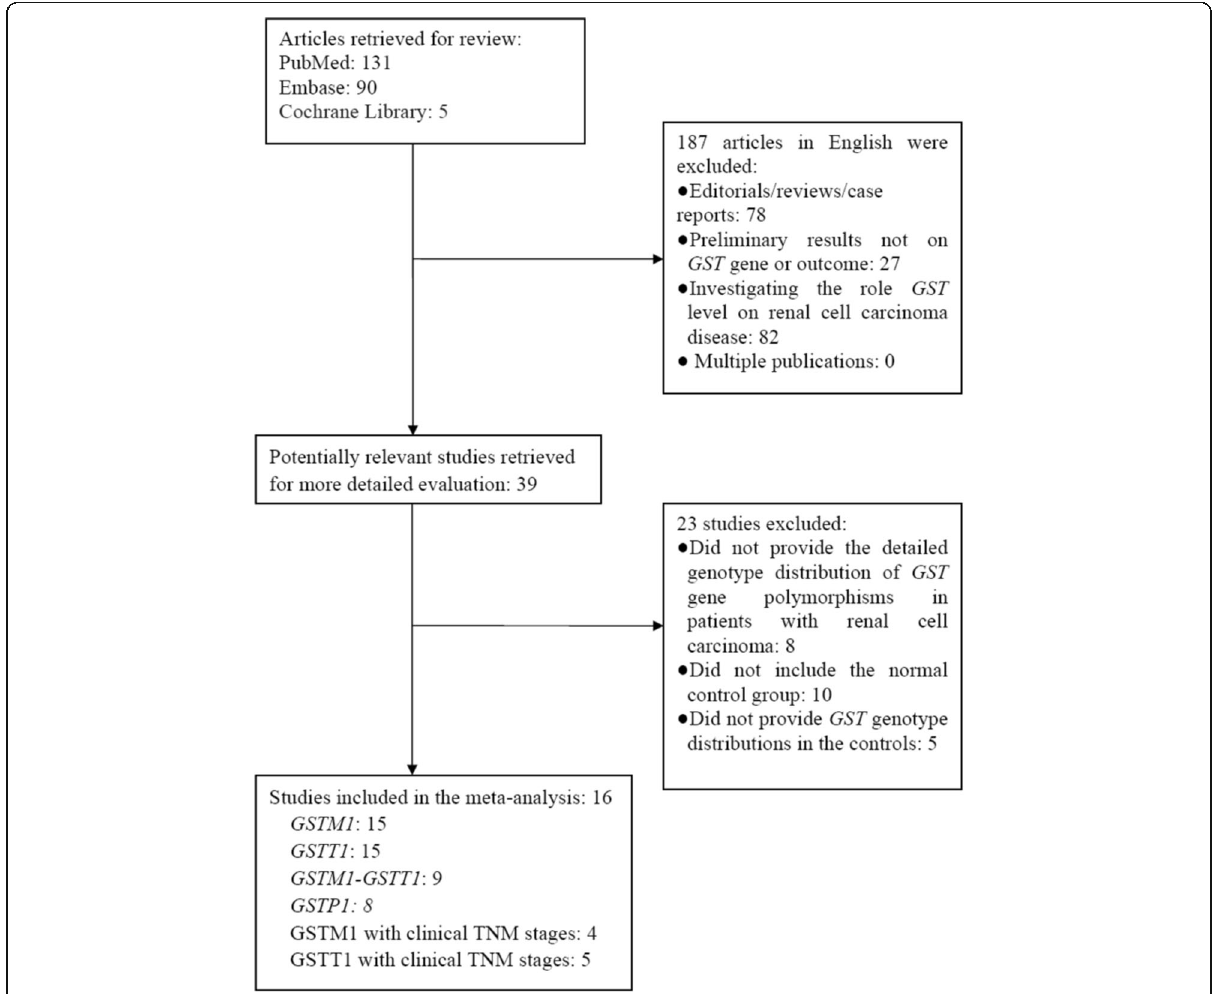
Fig. 1 Flow chart of the study search and